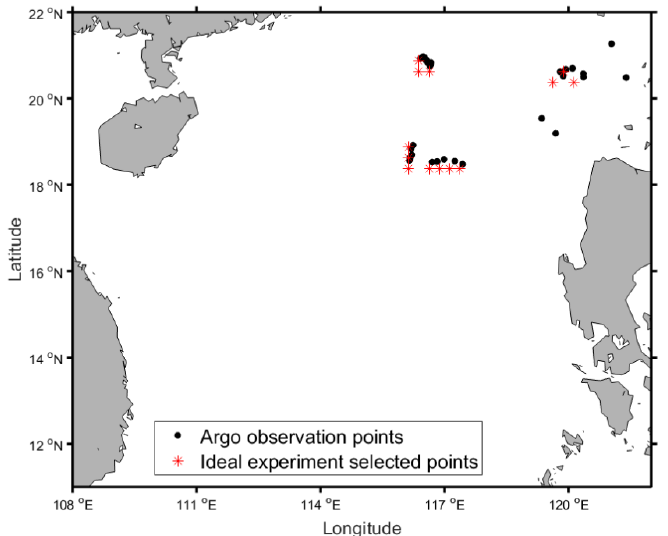
Figure 3. Vertical data position (the black dots denote Argo observation points, the red asterisks denote selected points in ideal experiment).